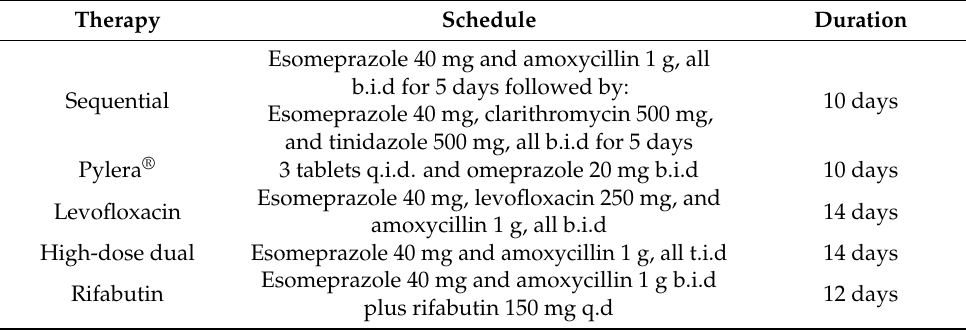
10 days 10 days